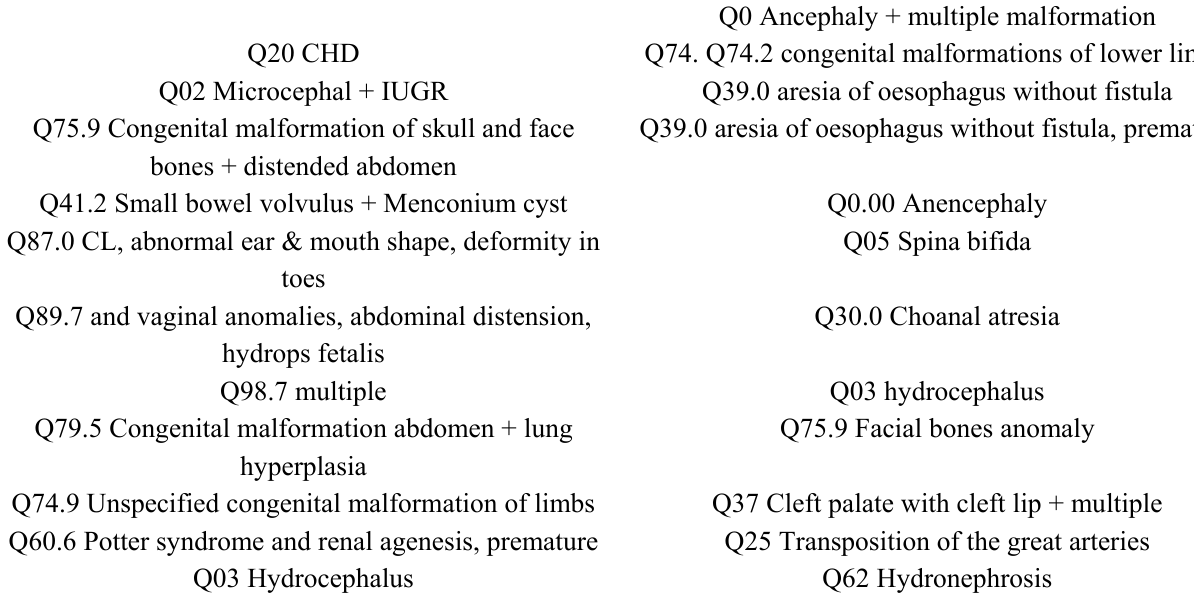
Table 3. List of the BD registered at birth. BD